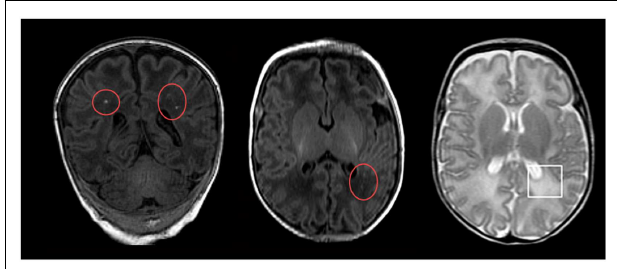
FIGURE 1 | Magnetic resonance imaging (MRI) of neonatal hypoxic-ischemia . Neonatal hypoxic-ischemia is a common cause of white matter injury, the underlying factor in the development of neonatal seizures. These manifest on MRI as either punctate white matter lesions (red circles; seen onT1-weighted MRI imaging) or diffuse excessive high signal intensity (white square; seen onT2-weighted MRI imaging). Reprinted from Wisnowski et al. (2013) under the terms of the Creative Commons Attribution License.